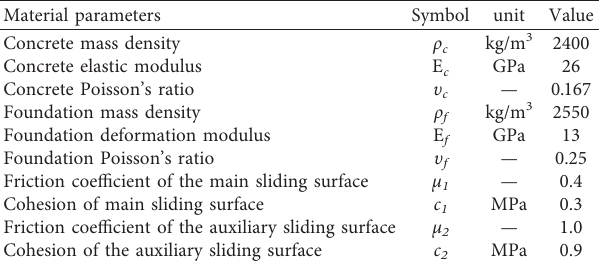
Figure 1: (a) Description of the typical nonoverflow monolith of the gravity dam (all dimensions are in meters). (b) Description of the sliding block. (c) Finite element mesh of the dam with the component of dam body, slide block, and truncated boundaries of foundation. Table 1: “Base-case” material properties for concrete and